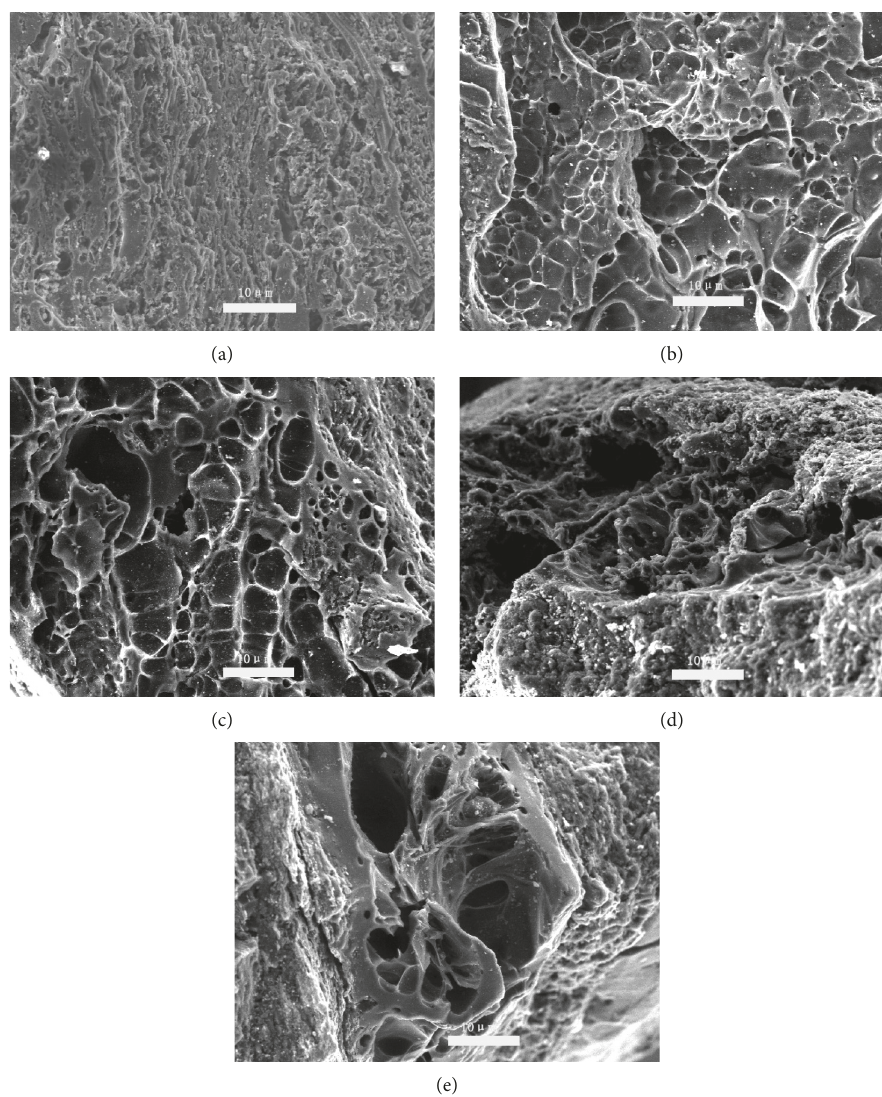
Figure 1: SEM photographs of BACs: (a) BAC-0, (b) BAC-N1, (c) BAC-N2, (d) BAC-N3, and (e)